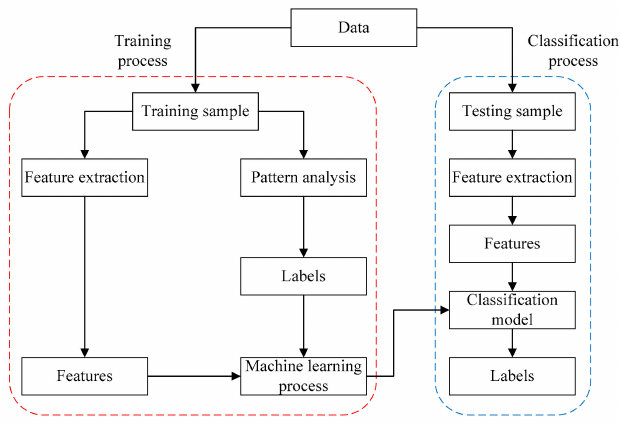
Figure 1. Flow chart illustration of classification